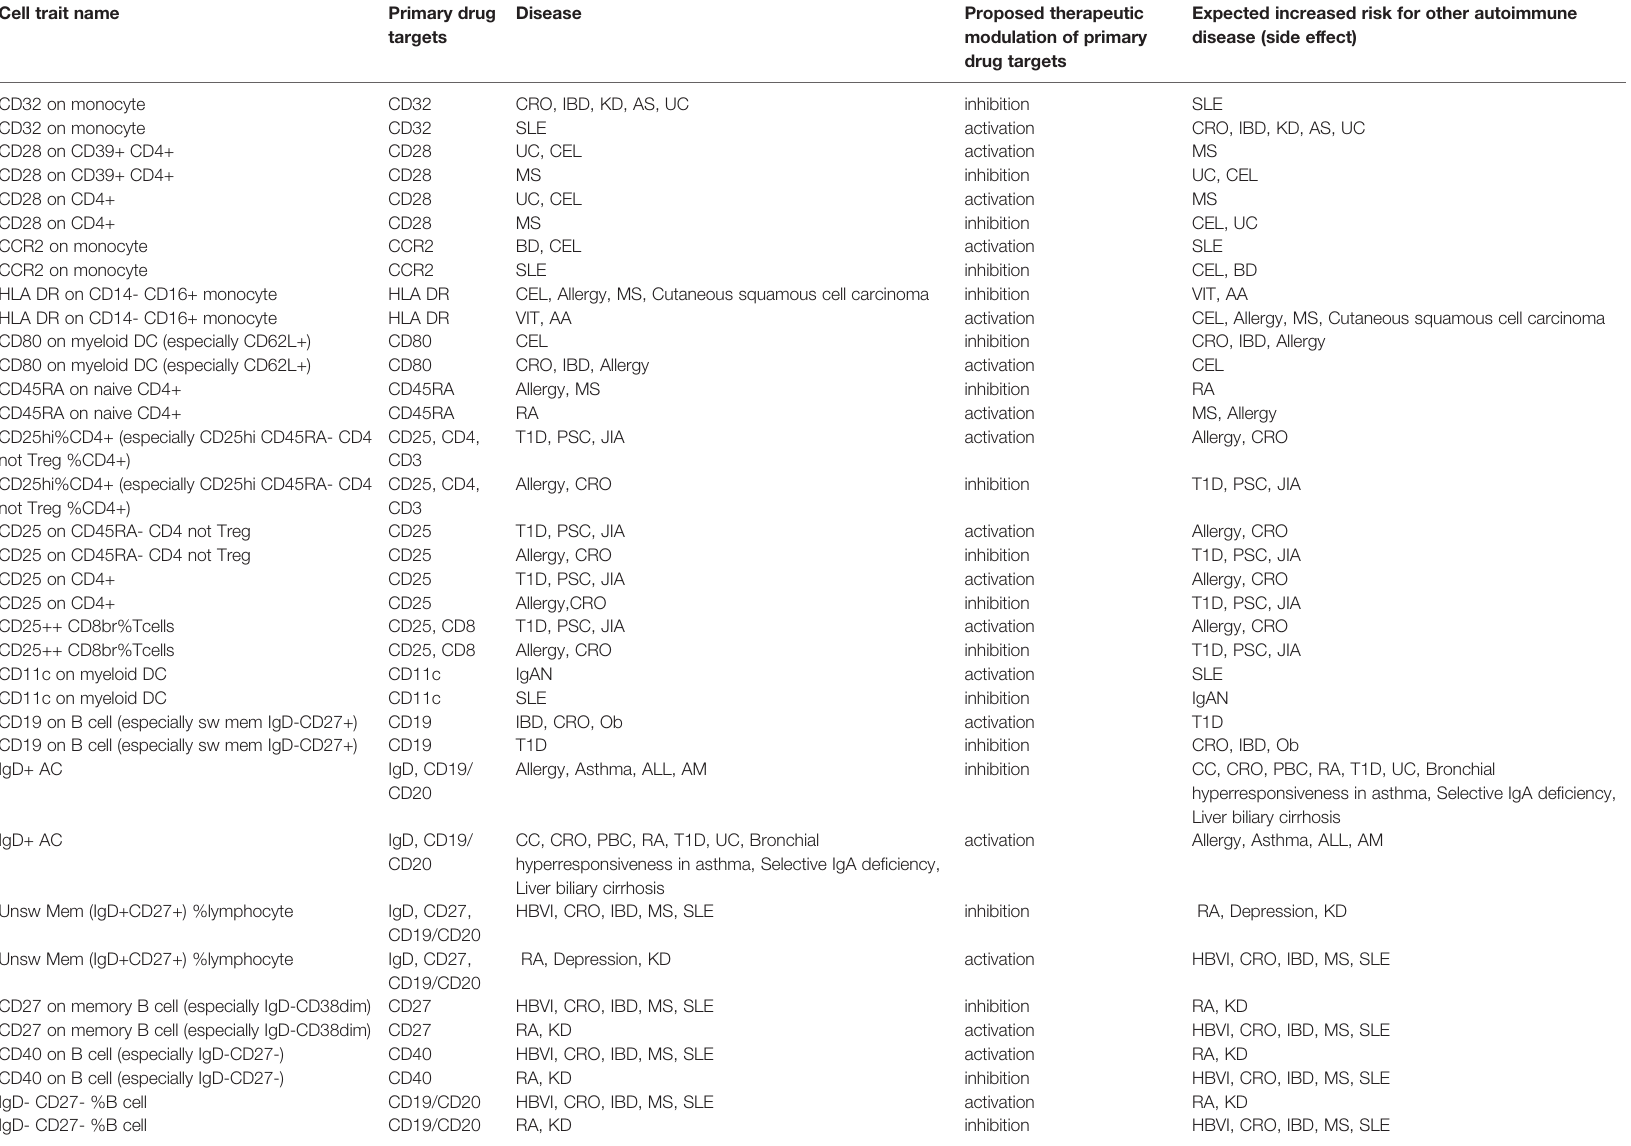
TABLE 1 | Immune traits associated with diseases via overlapping genetic association and having opposite direction of effect in different diseases. Extracted from Orrù et al., 2020